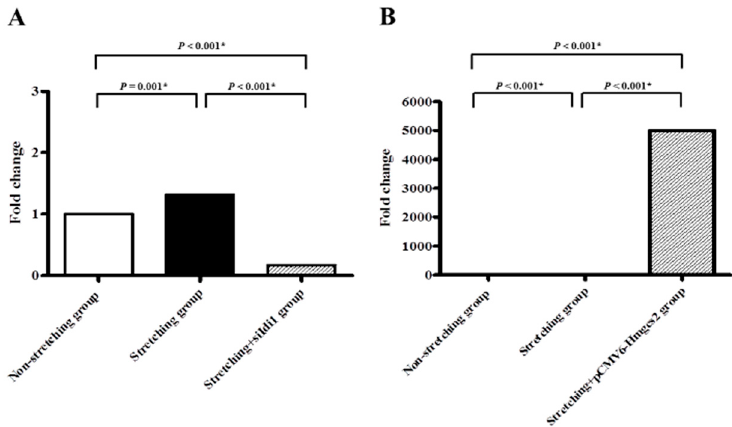
Figure 5. Quantitative determination of mRNAs by real-time RT-PCR in the HL-1 atrial myocytes. ( A ) Genetic silencing of Idi1 mRNA; ( B ) genetic modification (plasmid transfection, pCMV6- Hmgcs2 ) of Hmgcs2 mRNA. * p < 0.05.